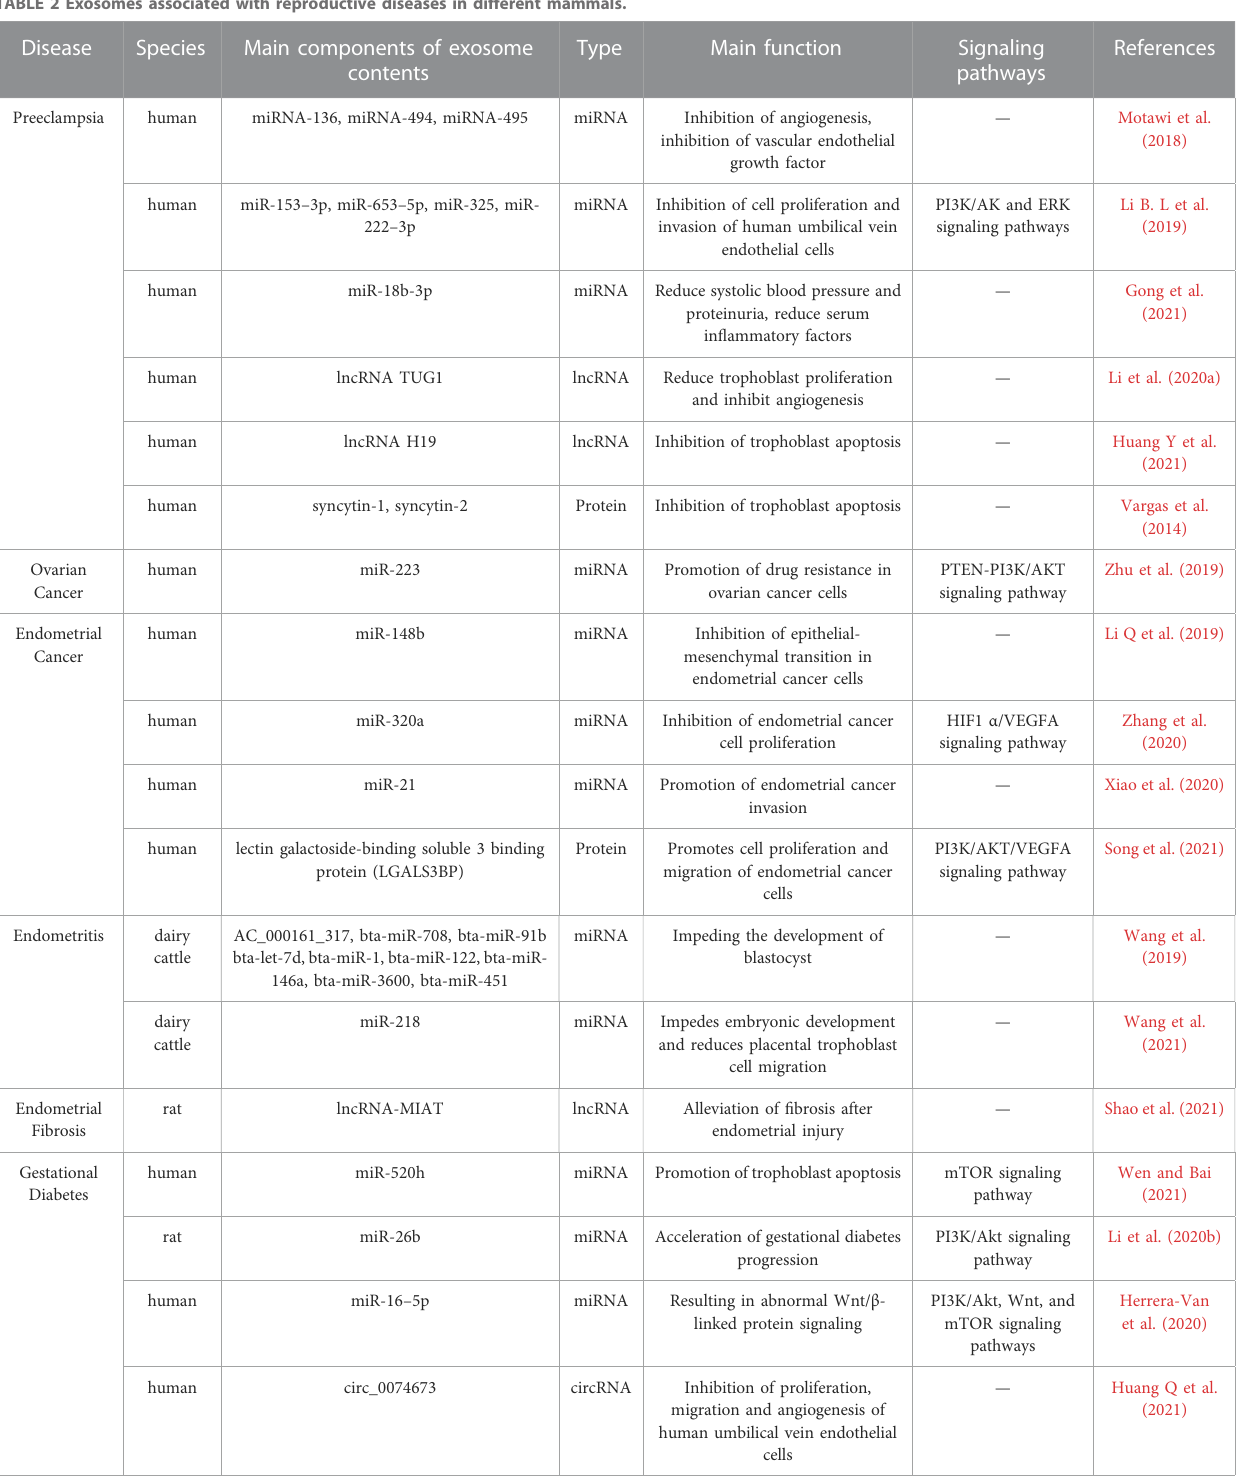
TABLE 2 Exosomes associated with reproductive diseases in different